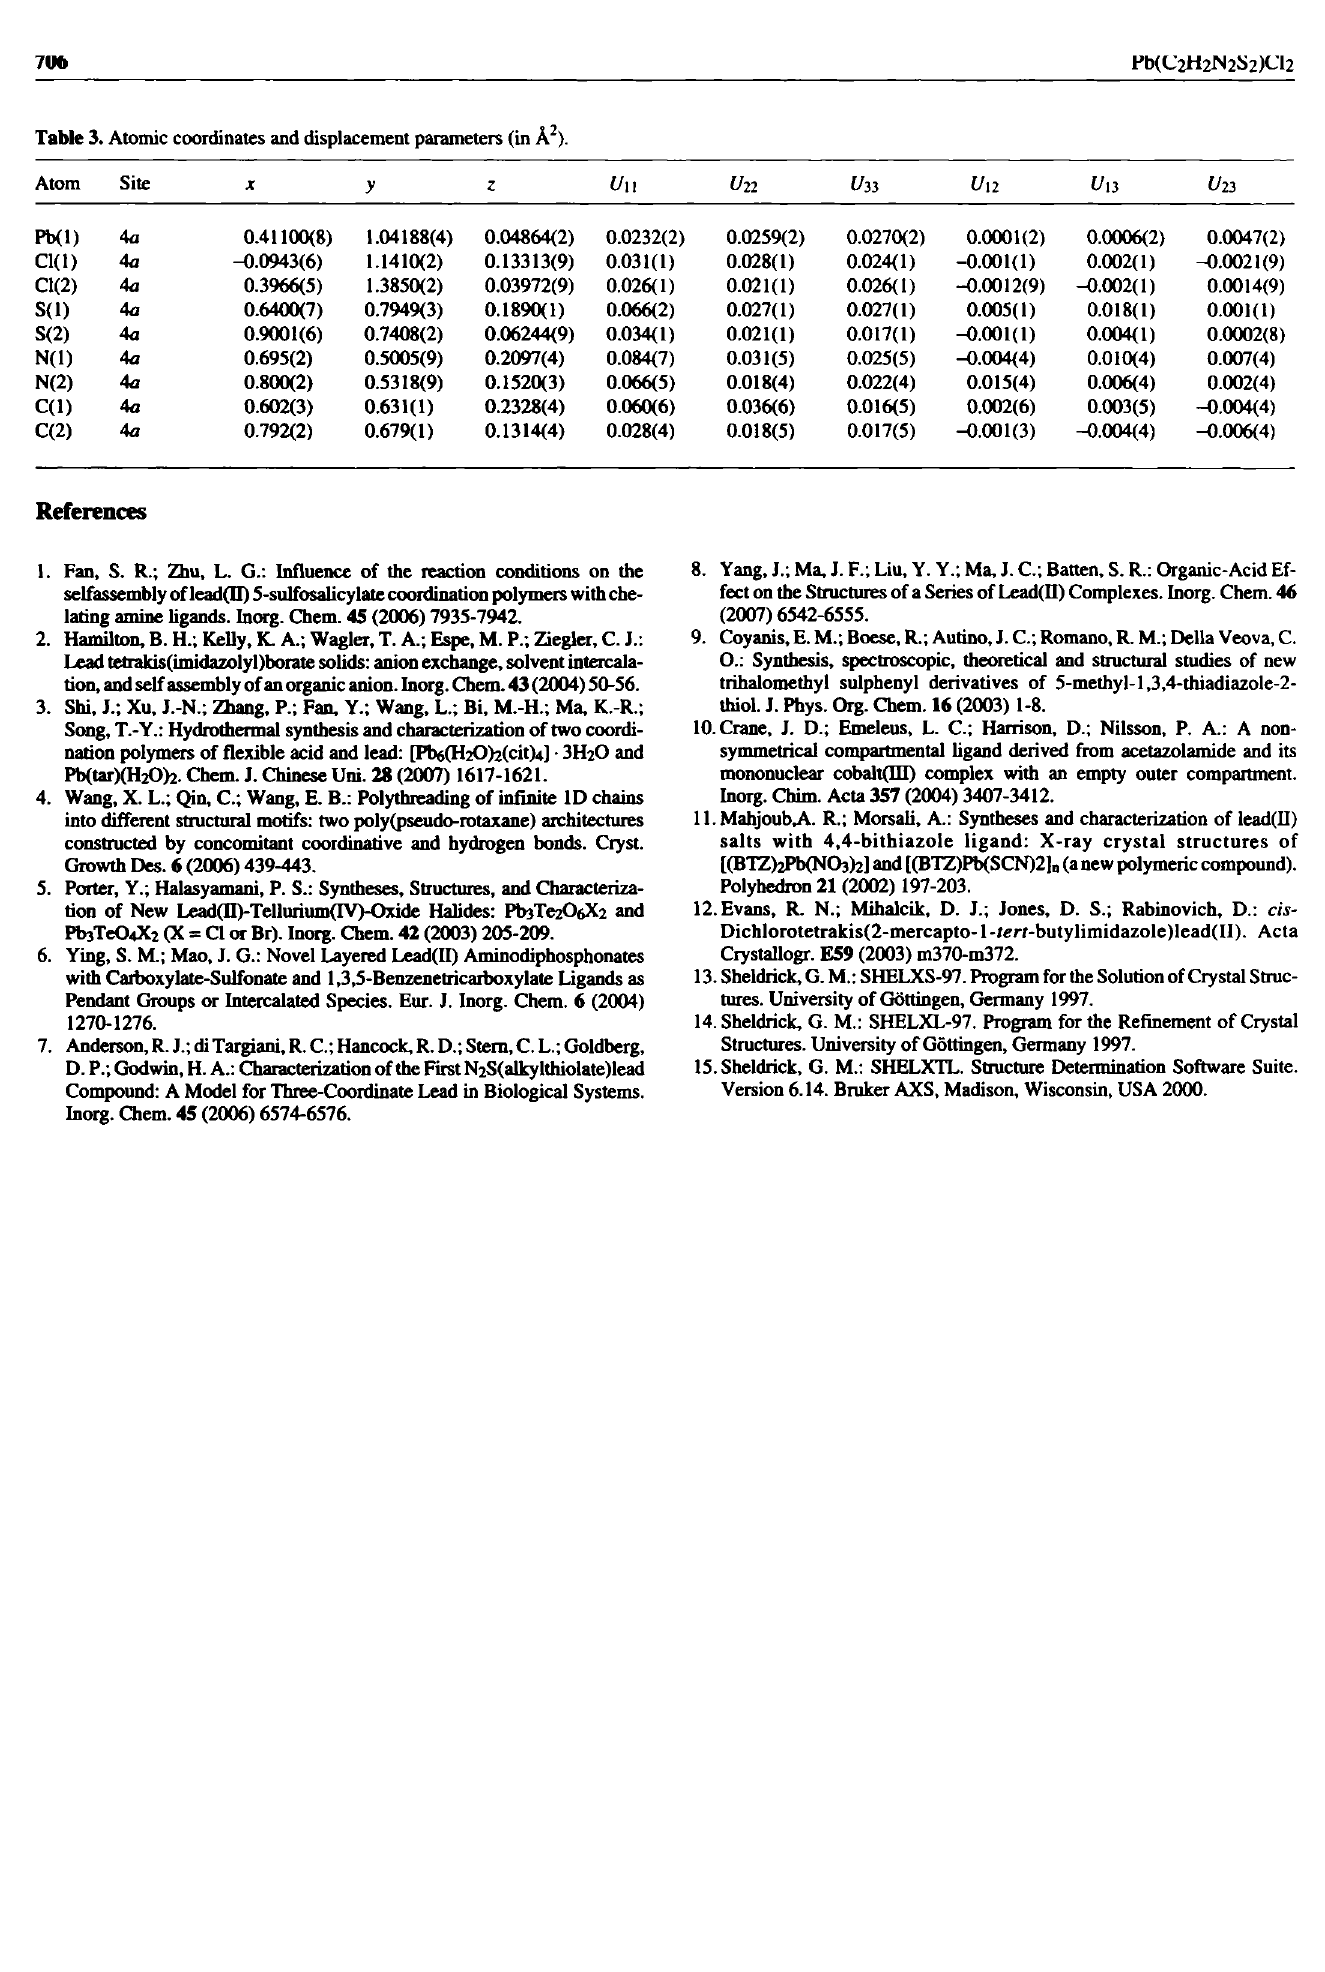
Table 3. Atomic coordinates and displacement parameters (in Â 2